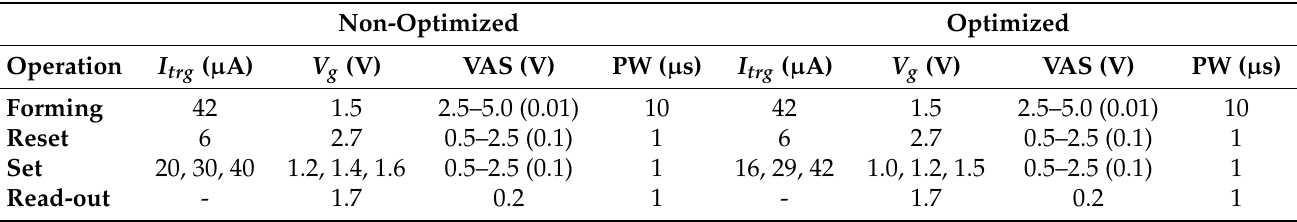
Table 1. Summary of M-ISPVA programming parameters used for the non-optimized and the optimized approaches during forming, reset, set, and read-out operations: target read-out current ( I trg ), gate voltage ( V g ), voltage amplitude sweep (VAS), and pulse width